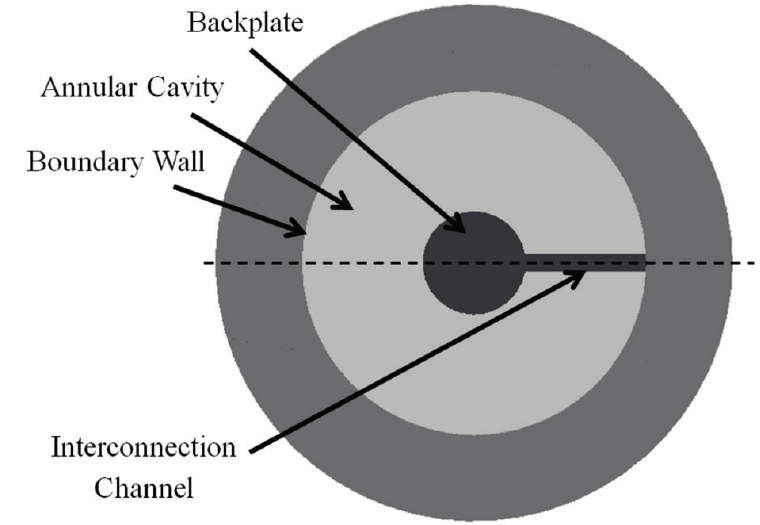
Figure 2. Schematic diagram of top view of the proposed acoustic sensor after removing the